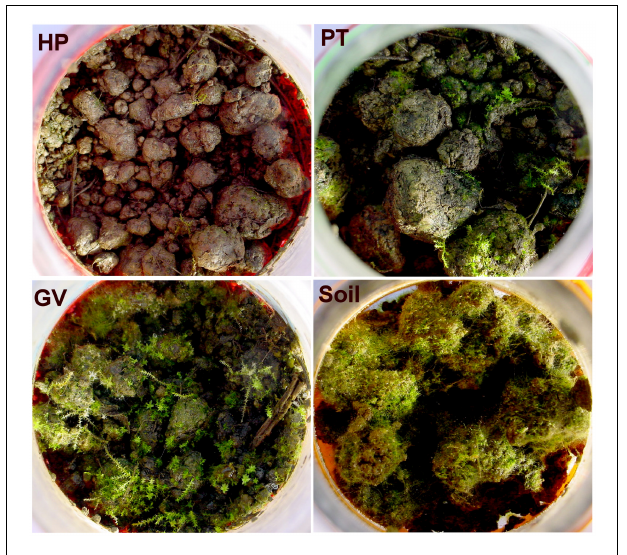
FIGURE 1 | Microcosm appearance after a 60-d incubation period: soil without added litter (lower right), soil with parental type litter (PT; upper right) litter, soil with litter from transformed poplars with a GUS vector (GV; lower left), and soil from transformed poplars with high proanthocyanidin content (HP; upper left).